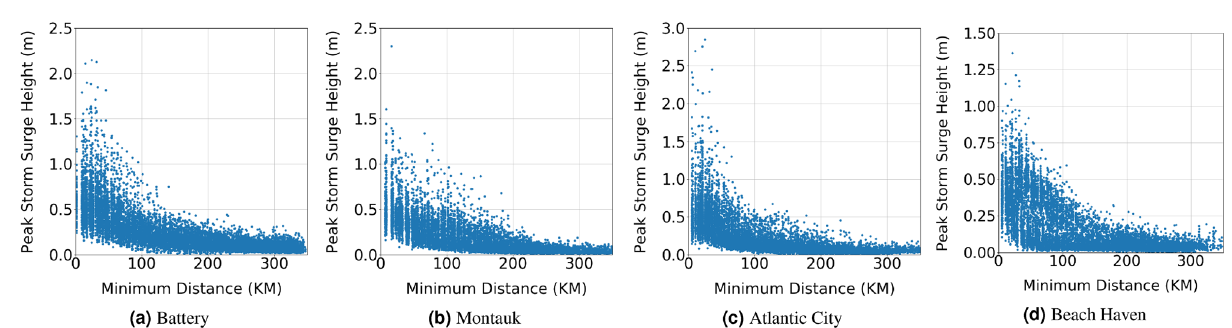
Figure 3. Scatter plots between the peak storm surge height calculated using the high-fidelity ADCIRC + SWAN simulations and the minimum distance between the TC eye and the study Fig. 2c. The plot shows that the peak storm surge height follows a right skewed distribution with a mean value of 0.26 m and a median value of 0.17 m. Only 1500 TCs, i.e. about 15% of the simulated TCs, generated a peak storm surge height more than 0.5 m. Clearly, the data set is imbalanced and biased more to the smaller peak storm surge heights, which biases the trained ML model when considered as one set. The bias can be reduced by splitting the data set into smaller ones that are less biased. We used d min to split the data set as it has the highest impact on the peak storm surge height, as shown in the following section. Figure 3 shows a scatter plot between the minimum distance and corresponding peak storm surge height, which is used to choose the threshold value of d min . As shown in the plots, the peak storm surge height decreases as d min increases to approach an asymptote with a value less than 0.5 m beyond d min = 100 km. Also, the plots show that for d min more than 100 km, the peak storm surge height dropped to less than 1 m at the Battery and Montauk, and 0.5 m in Atlantic City and Beach Haven. This also can be seen from the histograms of peak storm surge height for TCs that pass within